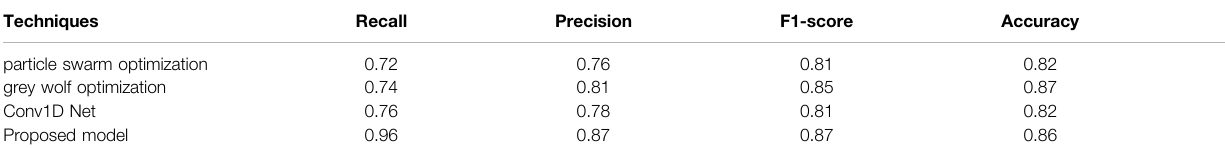
TABLE 3 | Performance evaluation of different techniques using different performance parameters.